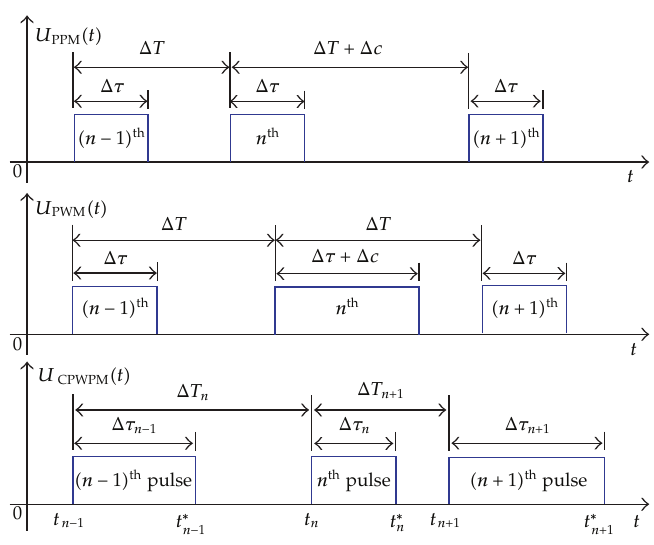
Figure 3: Illustration of the PPM, PWM, and CPWPM